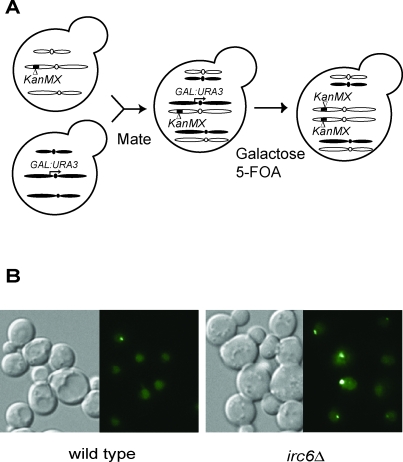
Rad52-YFP Focus Screen Using Systematic Hybrid LOH(A) Method for preparation of hybrid LOH strains for screening, permitting simultaneous complementation of recessive factors in the library strains and introduction of the Rad52-YFP plasmid through mating [12]. KanMX-marked gene deletion strains are mated with corresponding conditional centromere strains. Growth in galactose medium drives transcription through the centromere destabilizing the chromosome and 5-FOA selects for cells that have lost the conditional chromosome. In most cases, loss is followed by endoduplication of the monosomic chromosome, generating a 2n hybrid diploid homozygous for the gene deletion.(B) Spontaneous Rad52-YFP foci in a wild-type strain and in an irc6Δ deletion, a strain identified in the screen with an increased fraction of cells containing spontaneous foci.